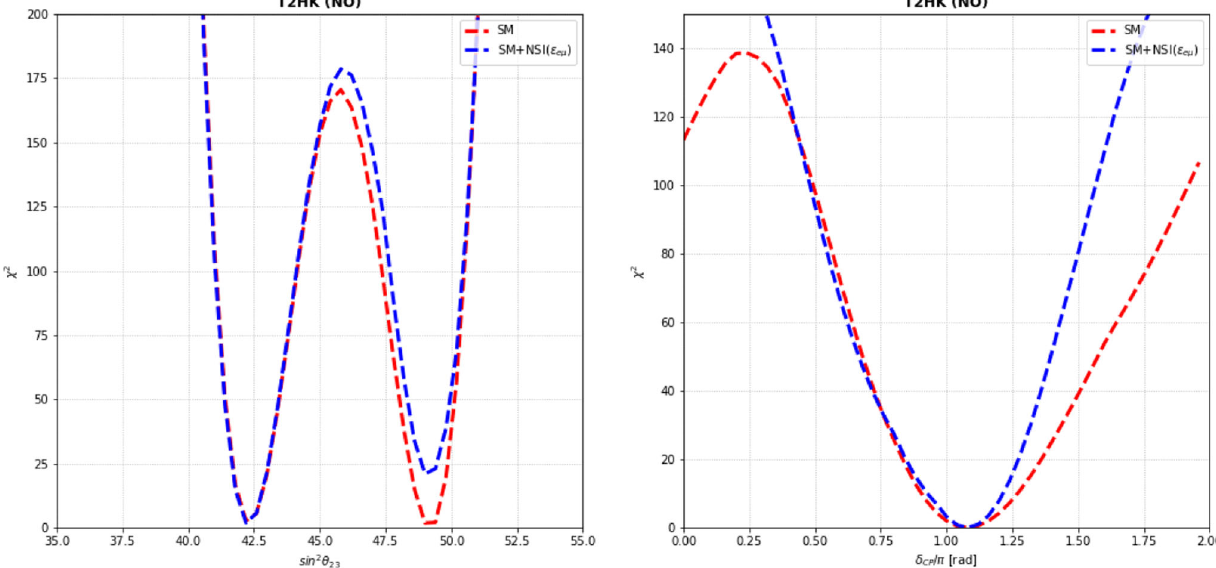
Fig. 5 One-dimensional projections of the standard parameters θ 23 (left) and δ CP (right) determined for T2HK in NO for SM (red dashed curves) and SM+NSI from e − μ scenario (blue dashed